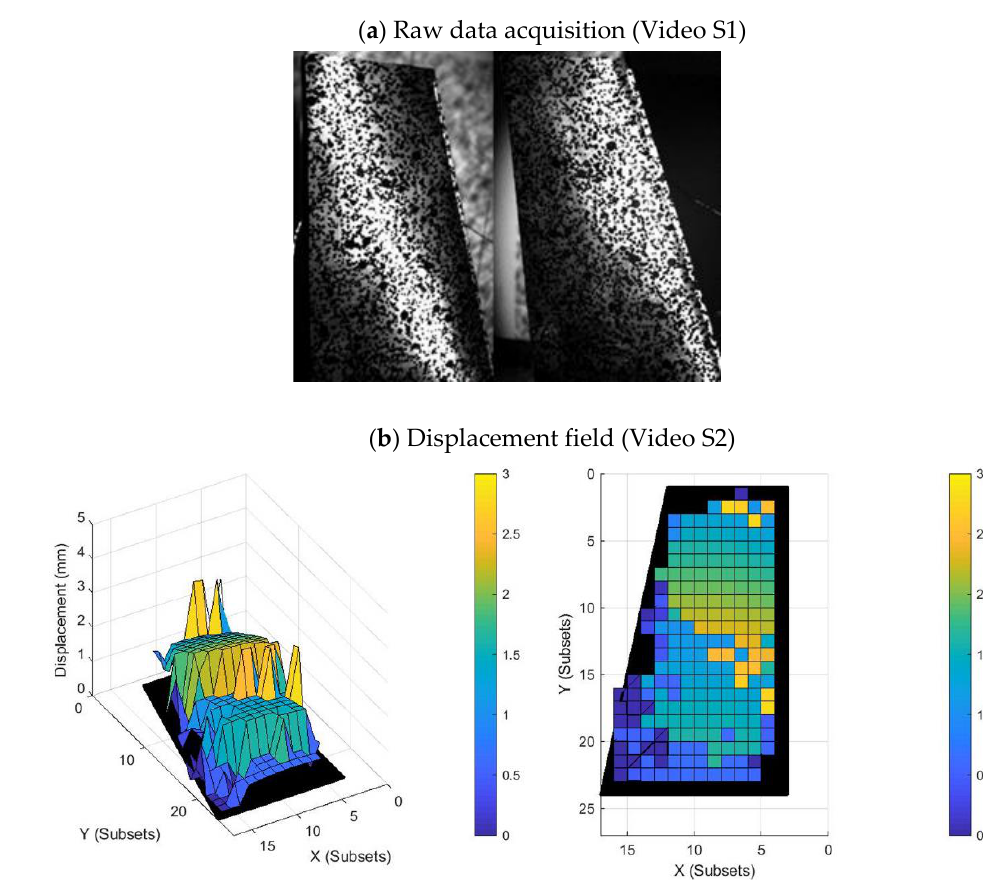
Figure 8. Static representations of the vibration mode for the first relevant natural frequencies from two different perspective points: ( a ) displacement field for 42.8 Hz, ( b ) displacement field for 57.5 Hz, ( c ) displacement field for 83.1Hz and ( d ) displacement field for 97.5 Hz. The color bars represent the displacement field (pixels).